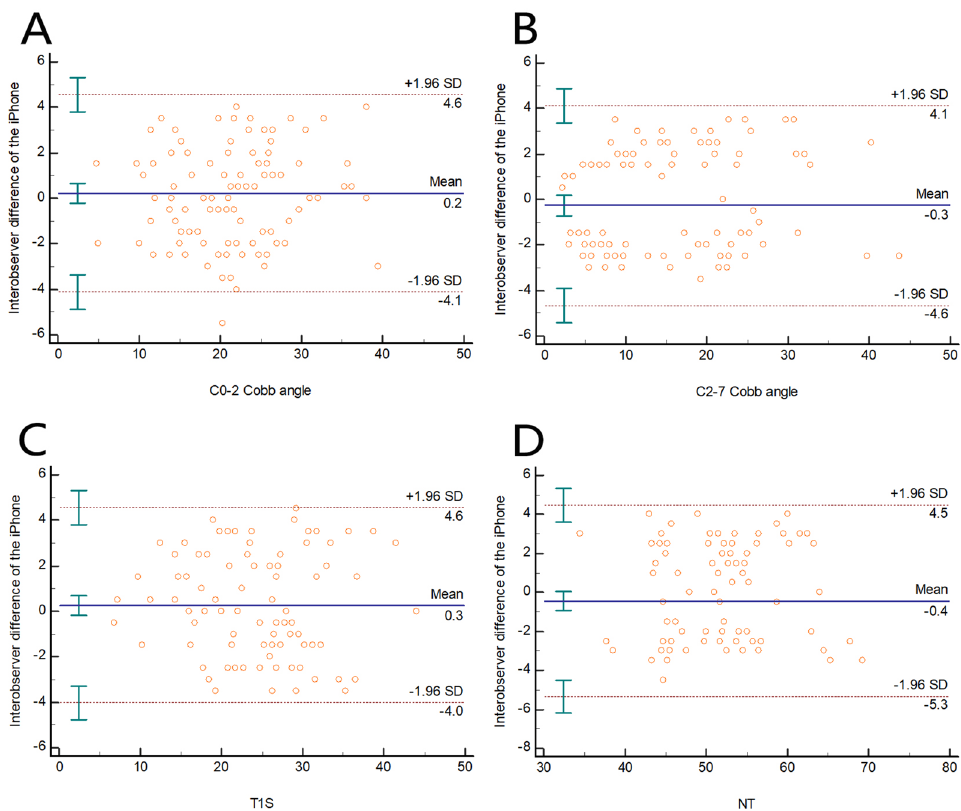
Figure 5. Bland ‒ Altman plot revealing the interobserver difference of the iPhone measurement for the ( A ) C0-2 Cobb angle, ( B ) C2-7 Cobb angle, ( C ) T1S, ( D ) NT. The mean difference is shown as the solid lines in the middle, and the 95% CI is presented as the outer two dotted